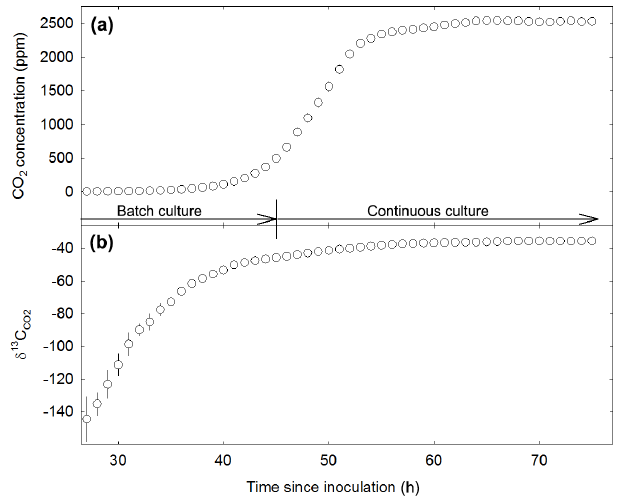
Figure 2. Example time course of the evolution of reactor headspace CO 2 concentration (a) and δ 13 C of the CO 2 (b) of the chemostat run at 23.5 ◦ C in hours since inoculation of the reactor with pre-cultured P. fluorescens . Data points are hourly means. Er- ror bars (where visible) denote ± 1 SD. The reactor was shifted from batch to continuous culture mode 45h after inoculation. Microbial respiration rate and the δ 13 C of respired CO 2 were measured be- tween 70 and 74h after inoculation when the culture reached steady